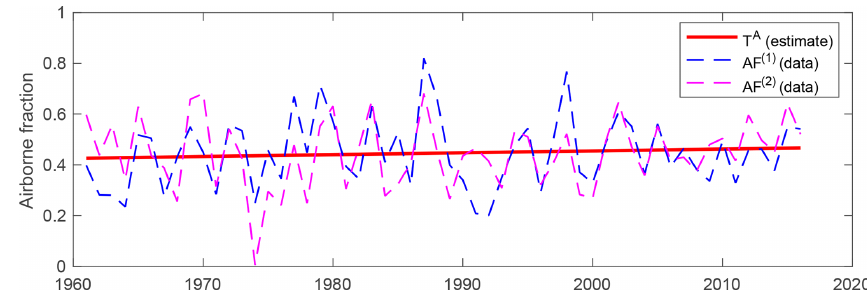
Figure 1. Estimated trend T A t of the airborne fraction from the model